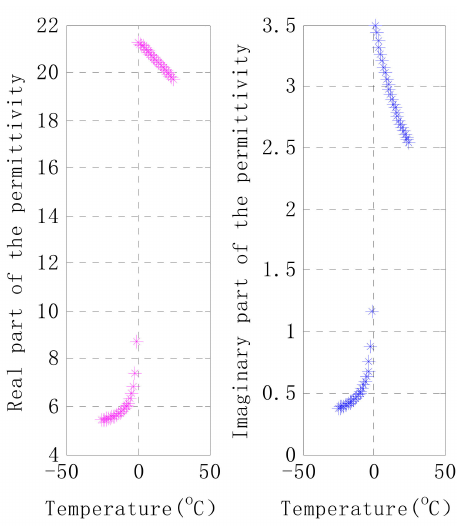
Figure 1. Real part ( Left ); and imaginary part ( Right ) of the permittivities versus soil temperature. Soil temperature changes from below 0 ◦ C to above 0 ◦ C.